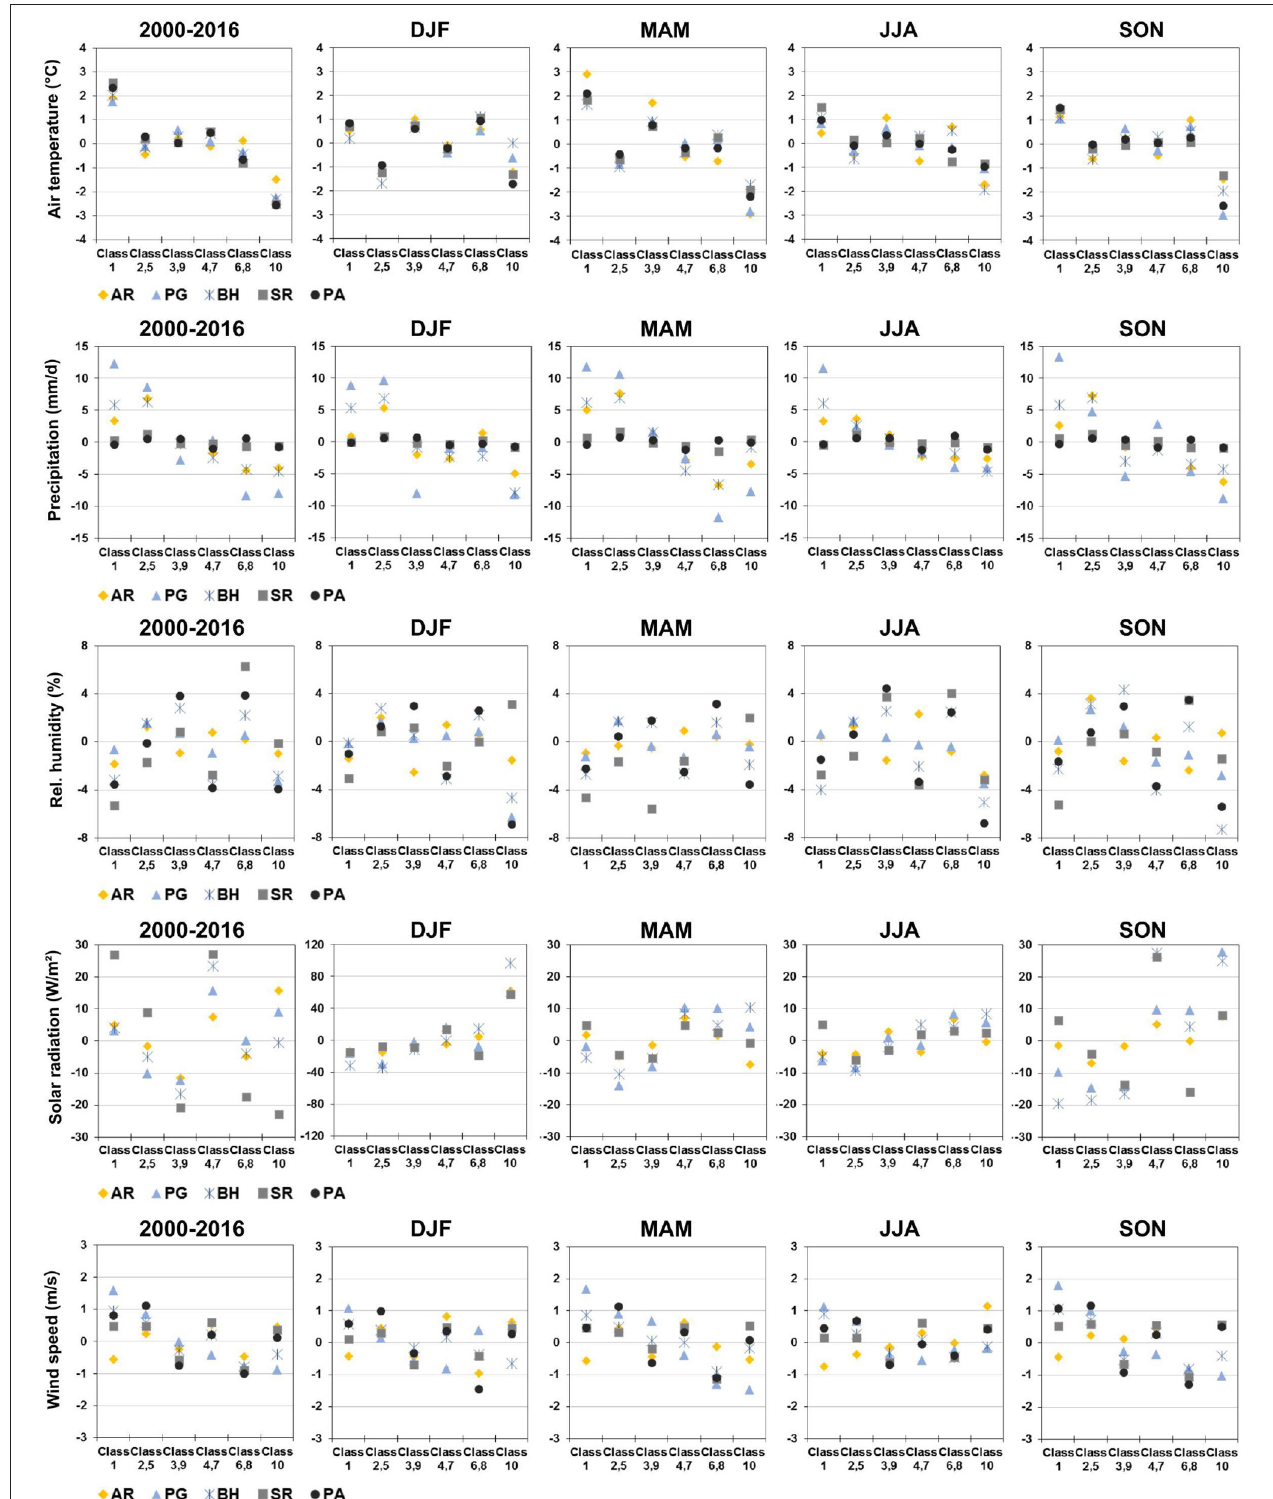
FIGURE 9 | Daily anomalies of air temperature, precipitation, relative humidity, solar radiation, and wind speed for each class of synoptic weather patterns between 2000 and 2016 and for summer (DJF), fall (MAM), winter (JJA), and spring (SON) between 2000 and 2016.